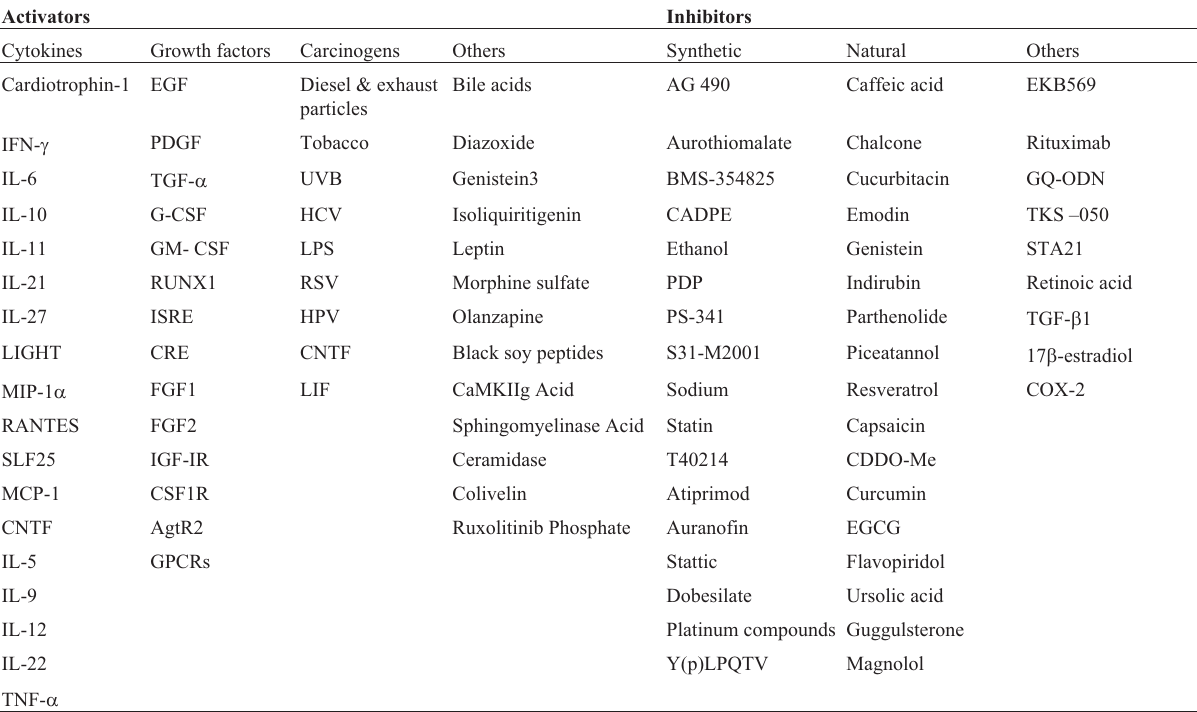
Table 1 - Activators and inhibitors of